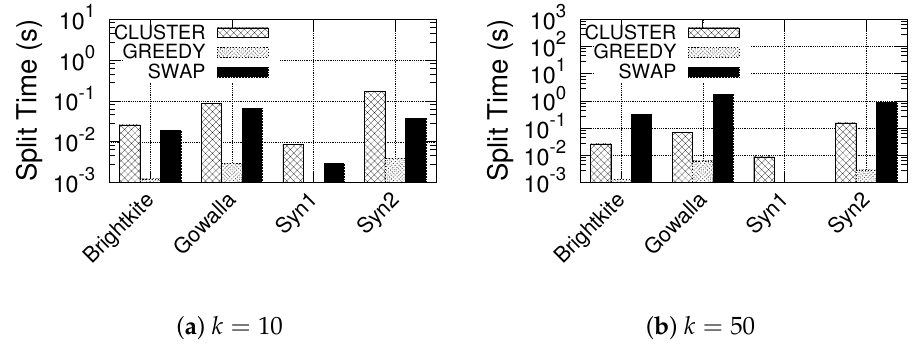
Figure 11. (Eval-VII) Split time of Greedy and Swap .